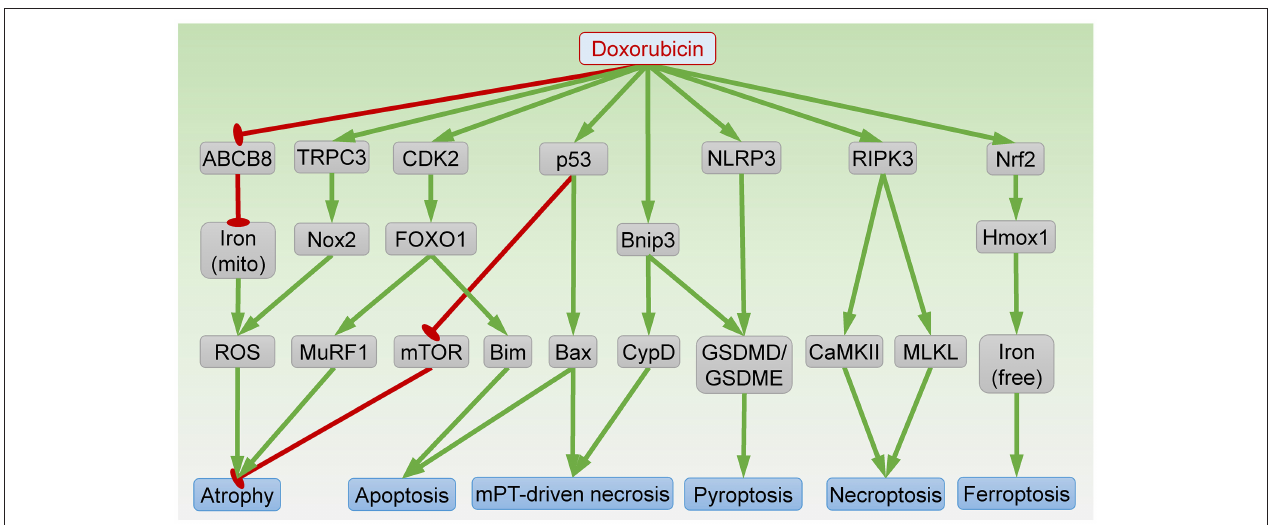
FIGURE 2 | Signaling pathways in DOX-induced cardiomyocyte atrophy and death. ABCB8, ATP-binding cassette protein-B8; CaMKII, Ca 2 + -calmodulin–dependent protein kinase; CDK2, cyclin-dependent kinase 2; CypD, cyclophilin D; FOXO1, forkhead box O1; GSDMD/GSDME, gasdermin D/E; Hmox1, heme oxygenase-1; mito, mitochondria; MLKL, mixed lineage kinase domain like pseudokinase; mPT, mitochondrial permeability transition; mTOR, mammalian target of rapamycin; MuRF1, muscle RING finger 1; Nox2, NADPH oxidase 2; RIPK3, receptor-interacting protein kinase 3; ROS, reactive oxygen species; NLRP3, NLR family pyrin domain containing 3; TRPC3, transient receptor potential canonical 3. Arrows indicate activation; bar-headed lines indicate inhibition.